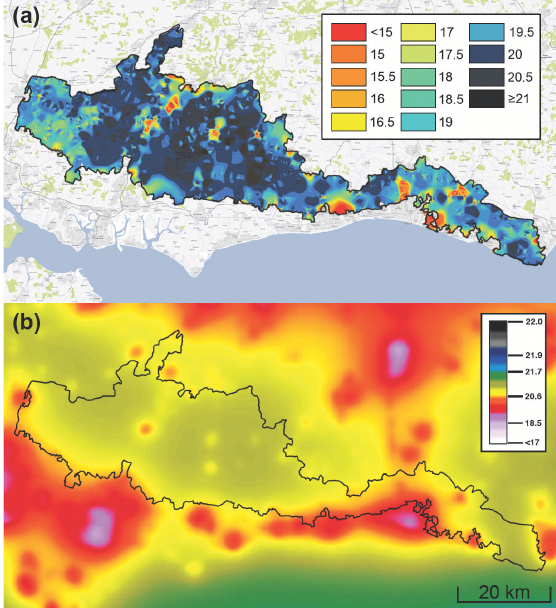
Figure 5. Two methods of estimating the spatial distribution of zenithal night sky brightness over South Downs National Park, England. ( a ) Interpolated map of over 20,000 individual Sky Quality Meter measurements obtained in 2014–2015 during the park’s bid for International Dark-Sky Association (IDA) International Dark Sky Reserve status. ( b ) Map of implied visual-band zenith luminance derived from remote sensing measurements of upward radiance described in [1] during 2015. In both panels, the park boundary is indicated by the solid black line. The false colors in both maps indicate the sky luminance in units of magnitudes per square arcsecond; note that the colors in both maps correspond to different ranges of luminance. The 20-km scale bar at the lower right is common to both maps, and both are oriented according to the usual cartographic convention (north up, east